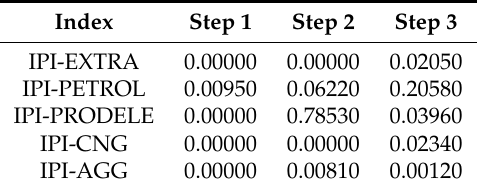
Table 29. Modified Diebold–Mariano for the equality of forecast accuracy of two forecasts under general assumptions with an expanding window from 2015:01 to 2018:12. The null hypothesis is that the two methods have the same forecast accuracy. The loss function is the absolute error.